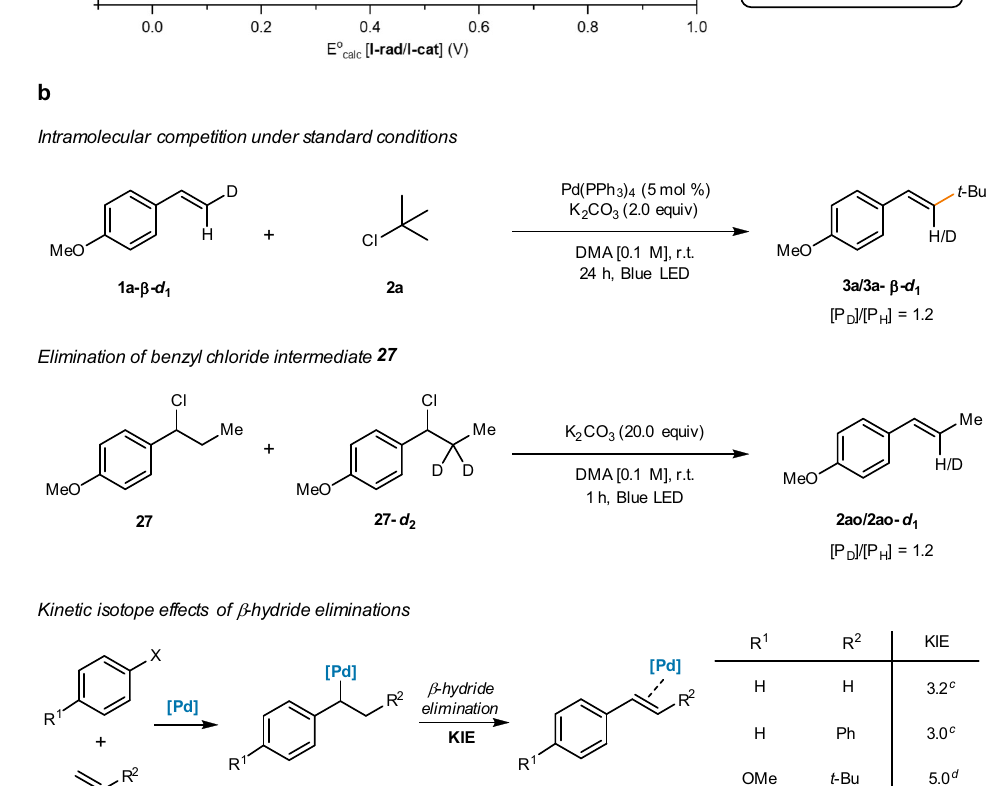
Fig. 3 Mechanistic studies on the product forming step. a Computed oxidation potentials of I-rad and associated reactivity trends. b Kinetic isotope effect measurements/computations. a Yields are isolated yields. b DFT computations were performed at the B3LYP-D3/6-311 + + G**/SDD//B3LYP-D3/6-31 G**/LanL2DZ level of theory in DMA (IEFPCM). The potentials are shown vs N.H.E. c From ref. 52 . d DFT-computed